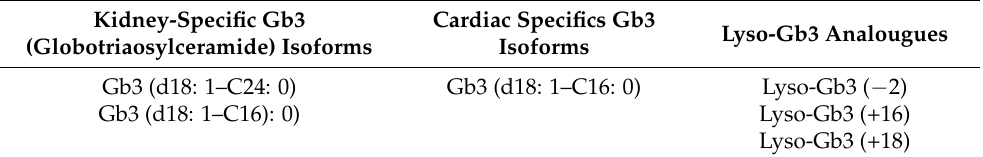
Figure 2. Lyso-Gb3 analogues and Gb3 isoform (A: Lyso GB3; B: Gb3 isoform). Table 1. Gb3 isoforms and